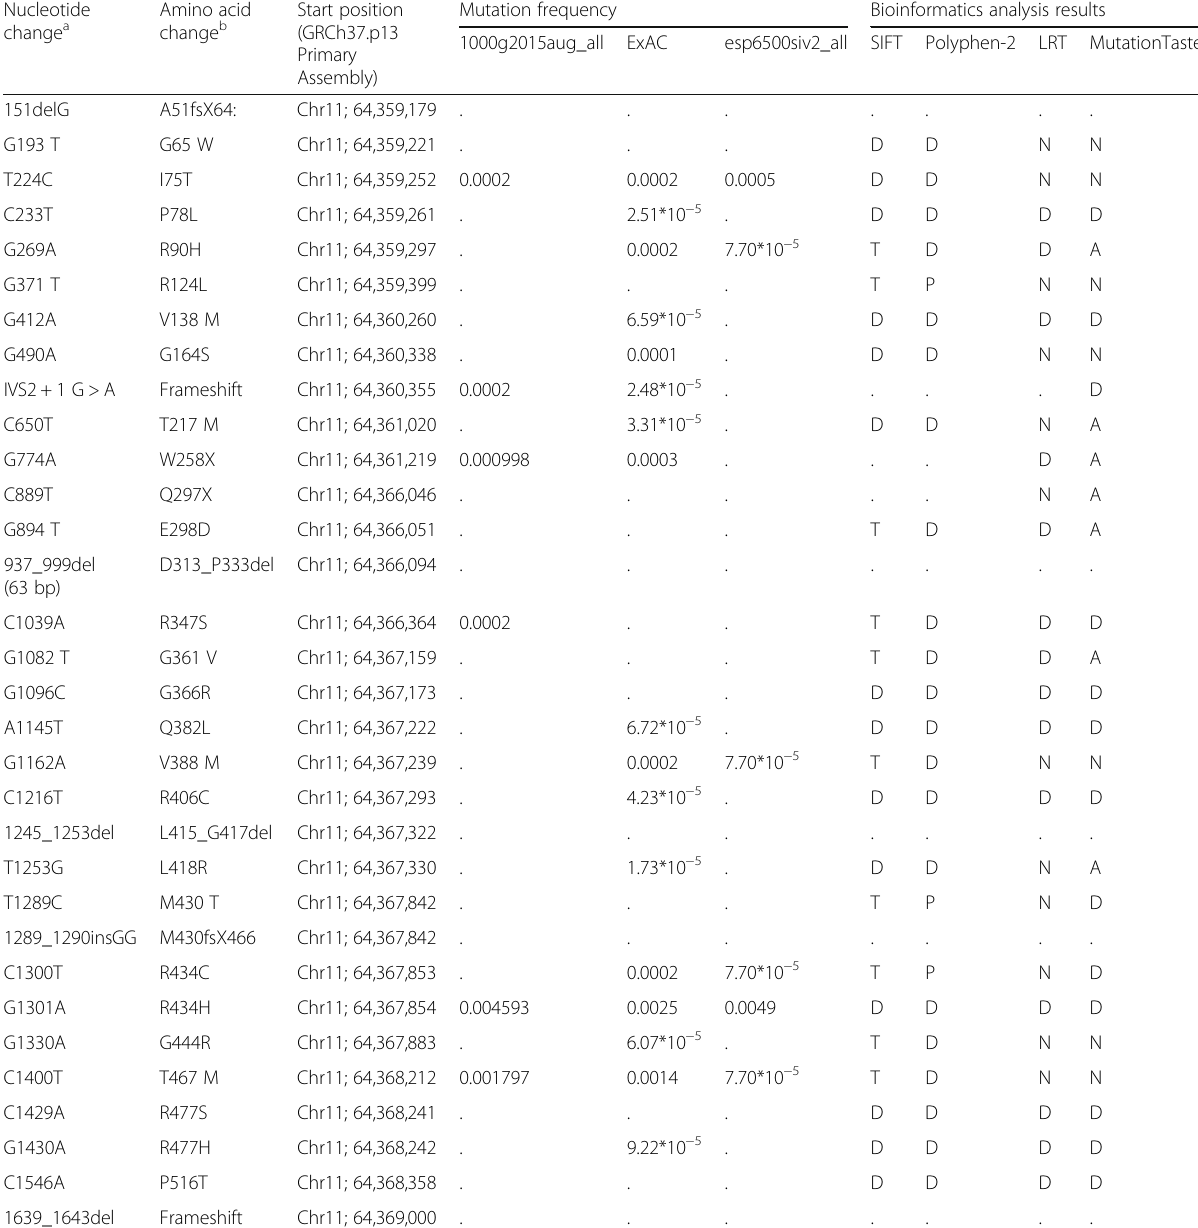
Table 5 Mutation frequency and pathogenicity prediction for all SLC22A12 mutations Nucleotide Amino acid change a change